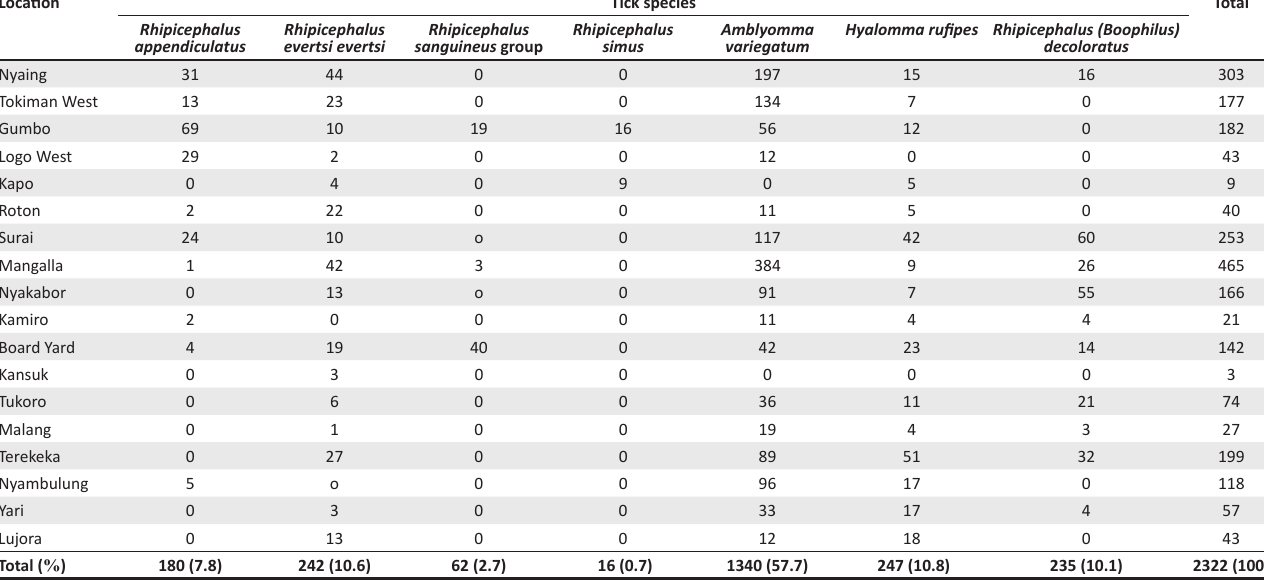
TABLE 1: Numbers of ticks collected on cattle at selected locations in the Central Equatoria region, Sudan (December 2004 and January–June 2005). Location Tick